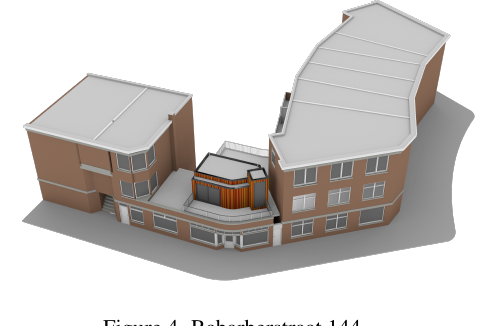
Figure 4. Rabarberstraat 144.